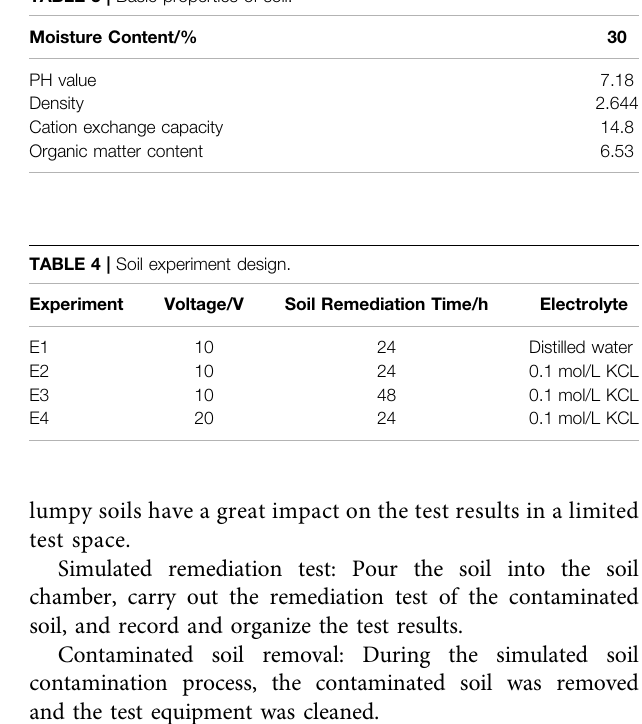
TABLE 3 | Basic properties of soil.